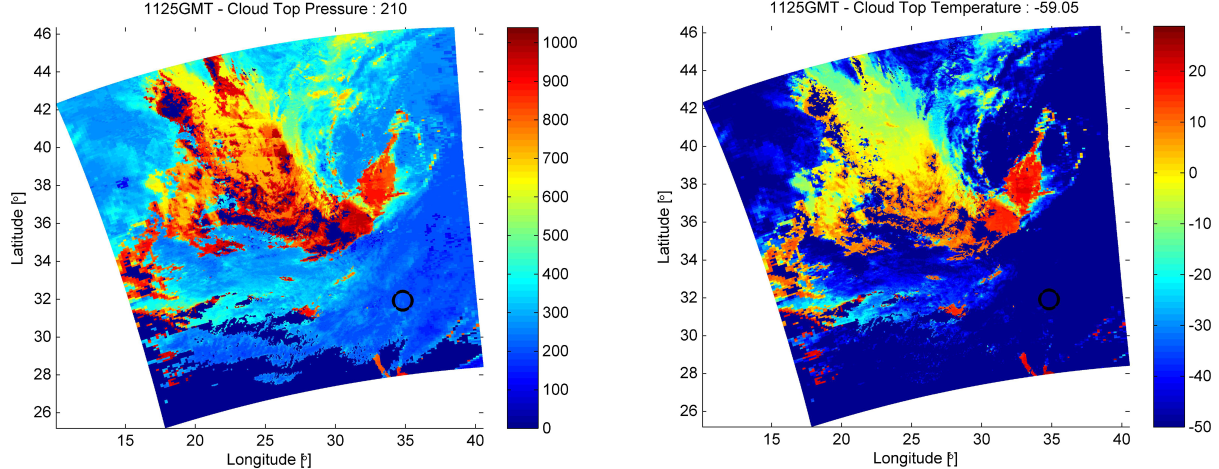
Fig. 11. MODIS cloud top pressure (210hPa) and temperature ( − 59.05 ◦ C) products. The SPECTATOR location is marked with a black circle at (34.79 ◦ E, 31.92 ◦ N).